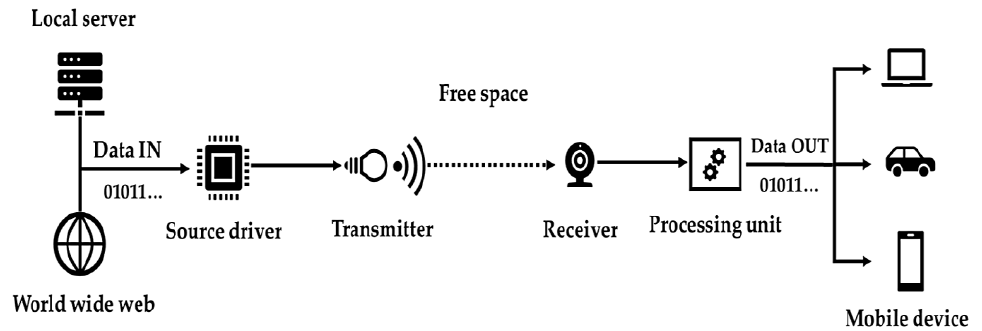
Figure 12. Implementation of a Li-Fi downlink channel on a technological level.